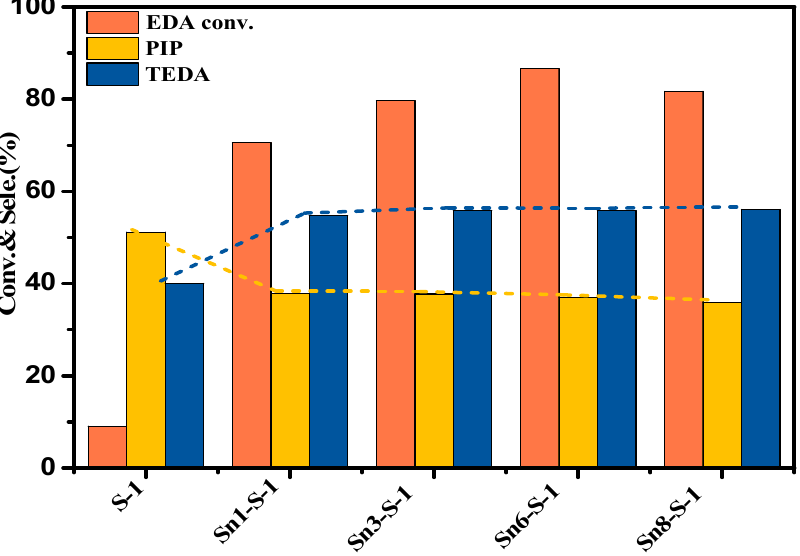
Figure 10. Effect of Sn loading on the conversion of EDA and the selectivity (to PIP and TEDA) of Sn-x-S-1 catalysts (for reaction conditions, see Figure 9).